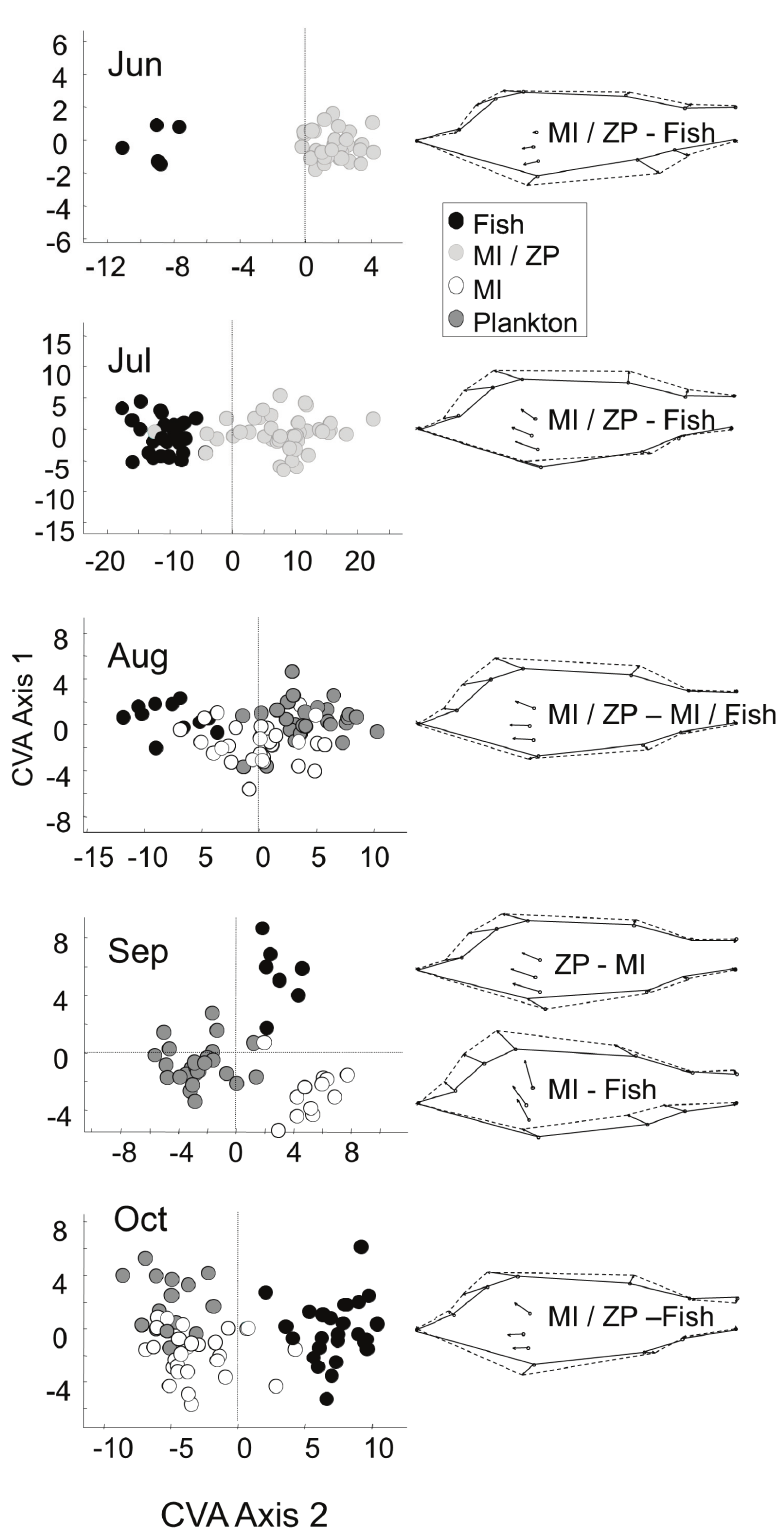
Fig 3. Morphometric analysis of perch. Left panel: canonicalvariates scores of perch in different clusters (the calculationof clusters was basedon stomach content analysis, Fig 1) throughout the season,